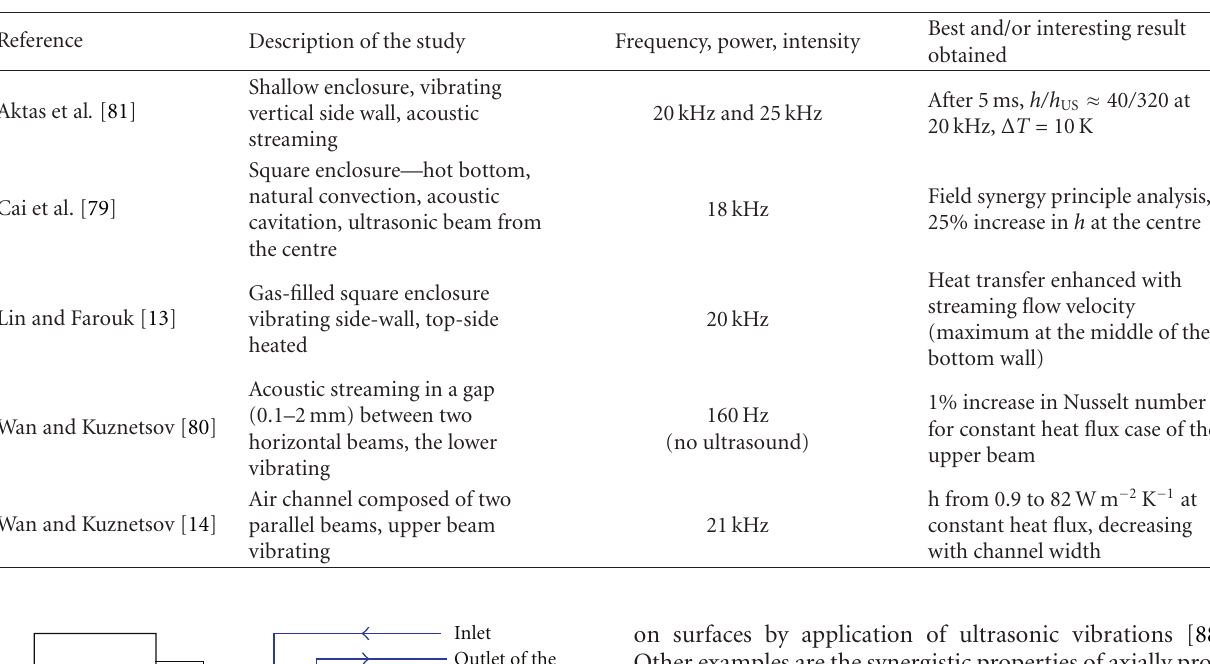
Table 5: Summary of numerical researches on convection increase by ultrasound.